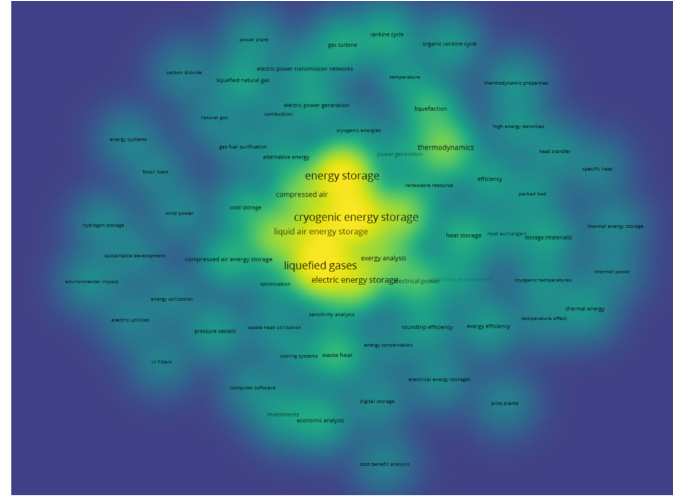
Figure 12. Co-occurrence of the keywords elaborated with